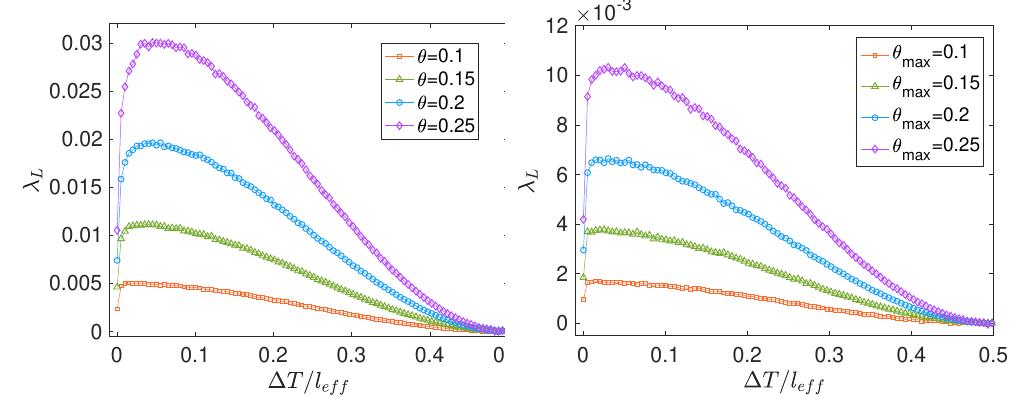
− 1 / 2 with as a function of ∆ T / l : = T θ / l θ L eff ,eff and H θ (cid:54) = , with θ = 0.1, 0.15, 0.2, 0 0 = p = 1 / 2. For N = ∞ , we choose 0 1 ] , where θ = 0.1, max max